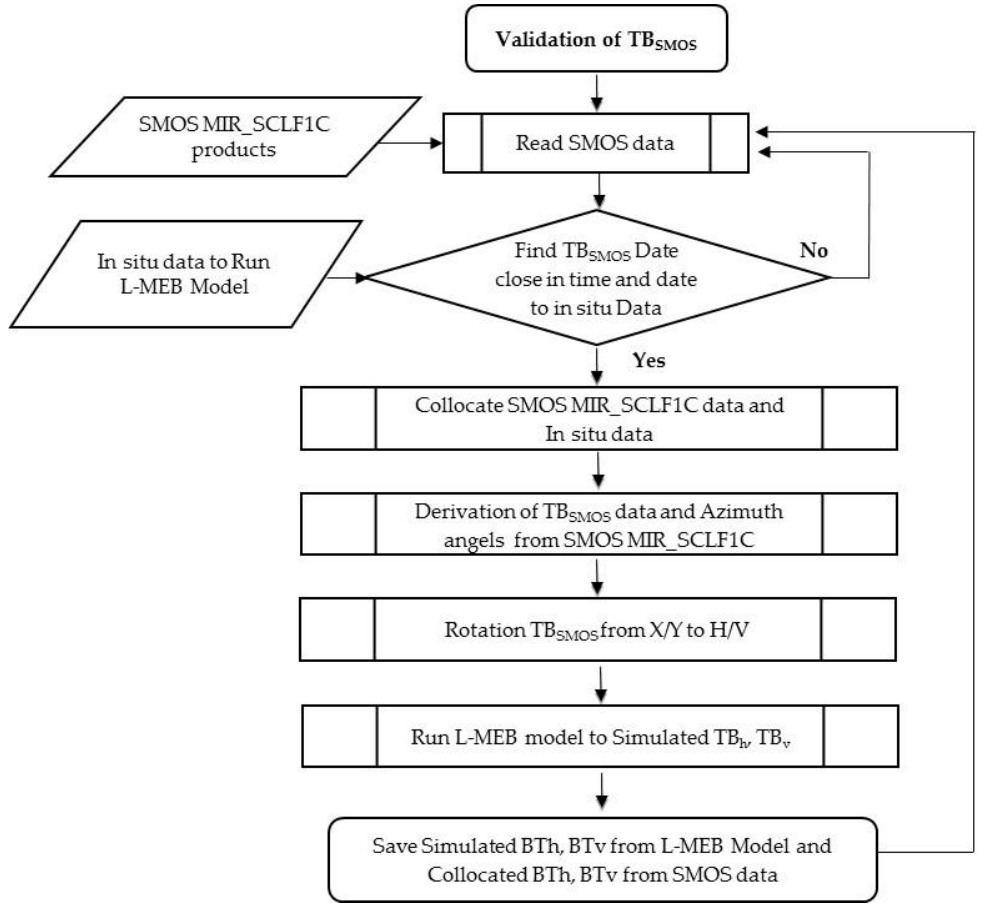
Figure 2. Flow chart of TB SMOS data validation algorithm.